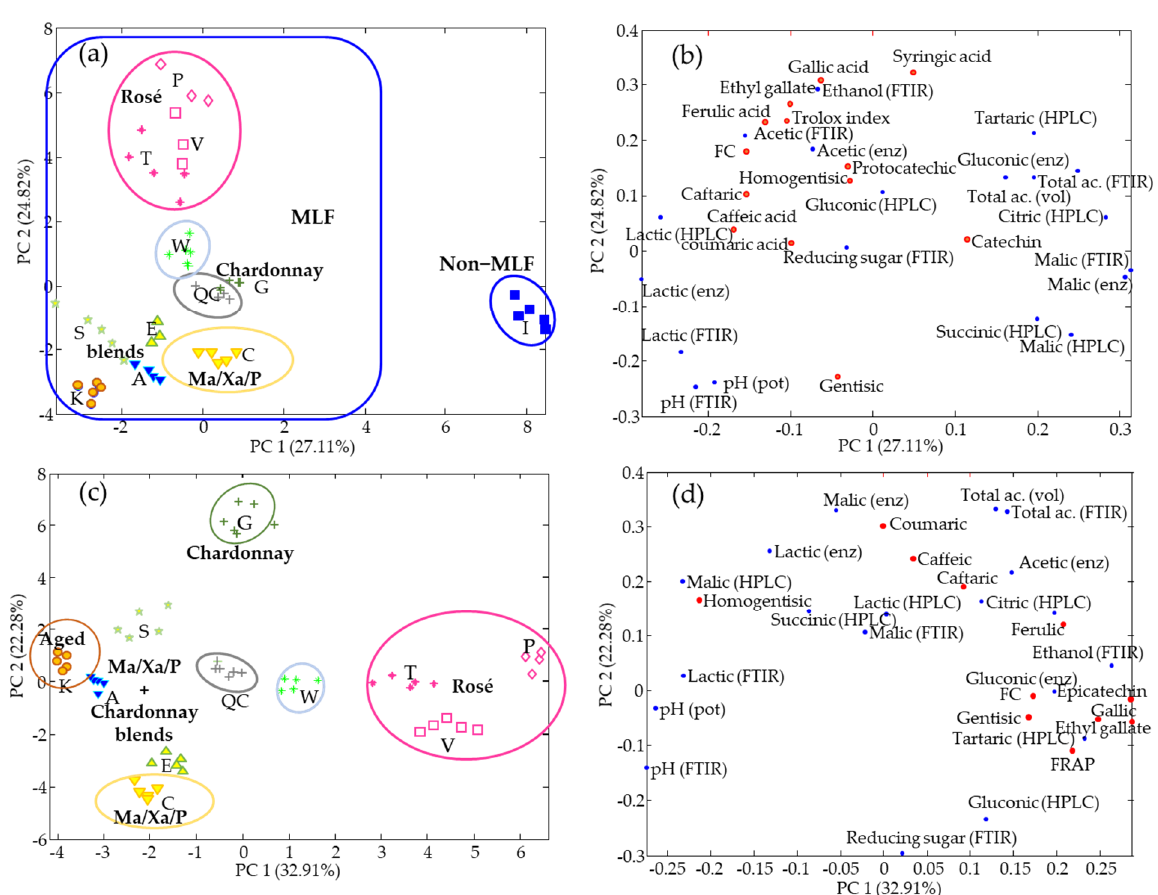
Figure 3. PCA results from the data fusion approach using phenolic and organic acid data. Plot of scores ( a ) and plot of loadings ( b ) using all types of samples. Plot of scores ( c ) and plot of loadings ( d ) excluding class I (i.e., without samples not subjected to MLF). Cava class assignation: see Table 2.